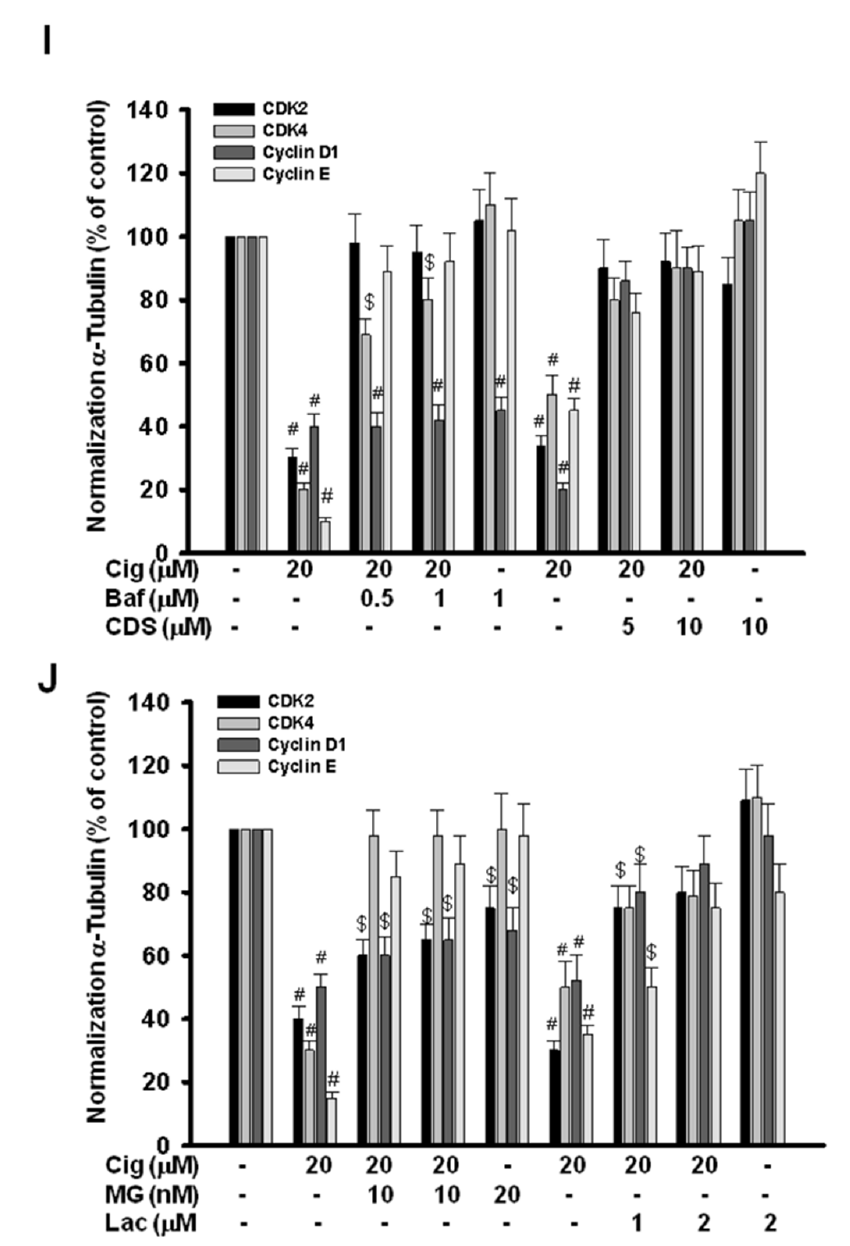
Figure 7. Assessment of cell cycle degradation proteins induced by ciglitazone. U87 were treated with ciglitazone in an escalated time course and analyzed for ER stress marker (calpain I/II), proteasome marker (ubiquitin), and lysosome marker (LAMP1) by Western blotting. U87 cells were also treated with ciglitazone and then by adding proteasome and lysosome inhibitors incubated for 24 h and analyzed for CDK2, CDK4, Cyclin D1, and Cyclin E by Western blotting. ( A ) Determination of calpain I/II in U87 cell line treated with ciglitazone (20 µ M) in time-dependent course. ( B ) Determination of ubiquitin in U87 cell line treated with ciglitazone (20 µ M) was in a time-dependent course. ( C ) Determination of LAMP1 in the U87 cell line treated with ciglitazone (20 µ M) was in a time- dependent course. ( D ) Determination of CDK2, CDK4, Cyclin D1, and Cyclin E in U87 cells treated with ciglitazone subjected to MG132 (MG) and Lactacystin (Lac) treatment. ( E ) Determination of CDK2, CDK4, Cyclin D1, and Cyclin E in U87 cells treated with ciglitazone subjected to Bafilomycin (Baf) and Chloroquine diphosphate salt (CDS) treatment. ( F ) Relative quantification (% of control) and normalization α -tubulin were evaluated in calpain-I and cal- pain-II. ( G ) Relative quantification (% of control) of Ubiquitin by densitometry in U87 cells treated with 20μM ciglitazone related to different time profile. ( H ) Relative quantification (% of control) of LAMP1 by densitometry in U87 cells treated with 20μM ciglitazone related to different time profile. ( I ) Cells pretreatment with Baf and CDS following ciglitazone exposure for protein detection. Rel- ative quantification (% of control) in CDK2, CDK4, Cyclin D1, and Cyclin E protein expression and normalization with α -tubulin were evaluated in U87 cells. ( J ) Cells pretreatment with MG and Lac following ciglitazone exposure for protein detection. Relative quantification (% of control) in CDK2, CDK4, Cyclin D1, and Cyclin E protein expression and normalization with α-tubulin were evaluated in U87 cells. Data are expressed as mean ± SD ( n = 6); * or # or $: p < 0.05 as compared with control. α−tubulin was loaded as a control.